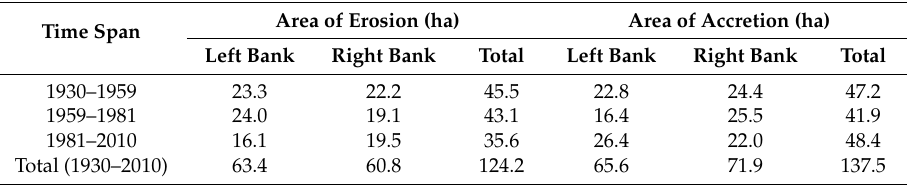
Table 1. Area of riverbank erosion and accretion of the Kolubara River from 1930 to 2010. Area of Erosion (ha) Area of Accretion (ha) Time Span Left Bank Right Bank Total Left Bank